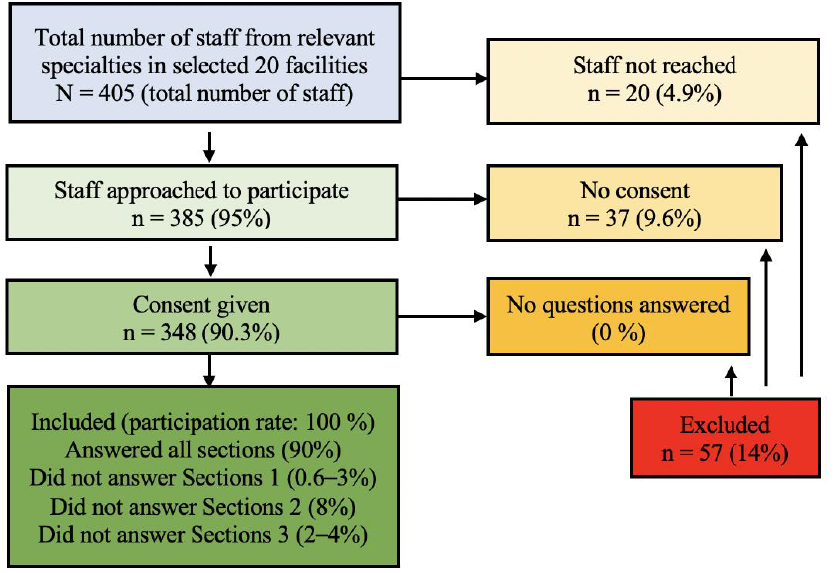
Figure 1. Flow chart of staff recruitment.